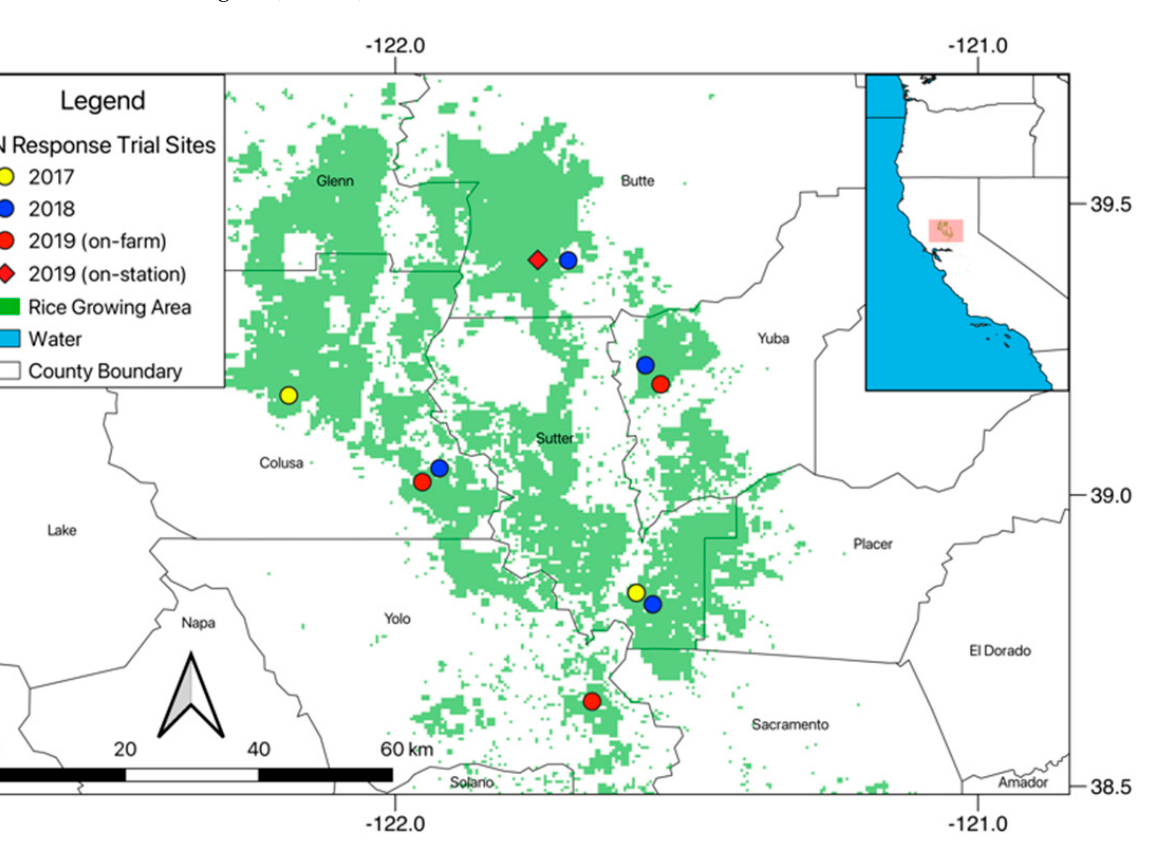
Table 1. Soil descriptions and selected properties of each N response trial site located throughout the Sacramento Valley, California.